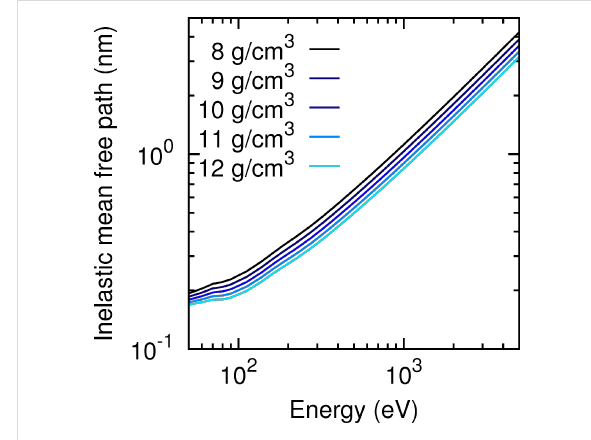
Figure 9: IMFP in the different deposits with fixed density ( ρ = 10.6092 g/cm 3 ) and a variable tungsten content.